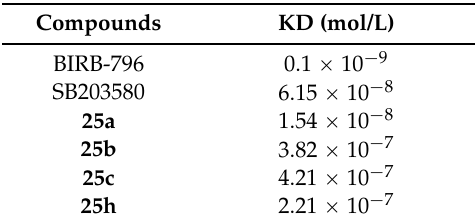
Table 2. Detailed binding analysis of small molecule inhibitors with p38 α mitogen-activated protein kinase.